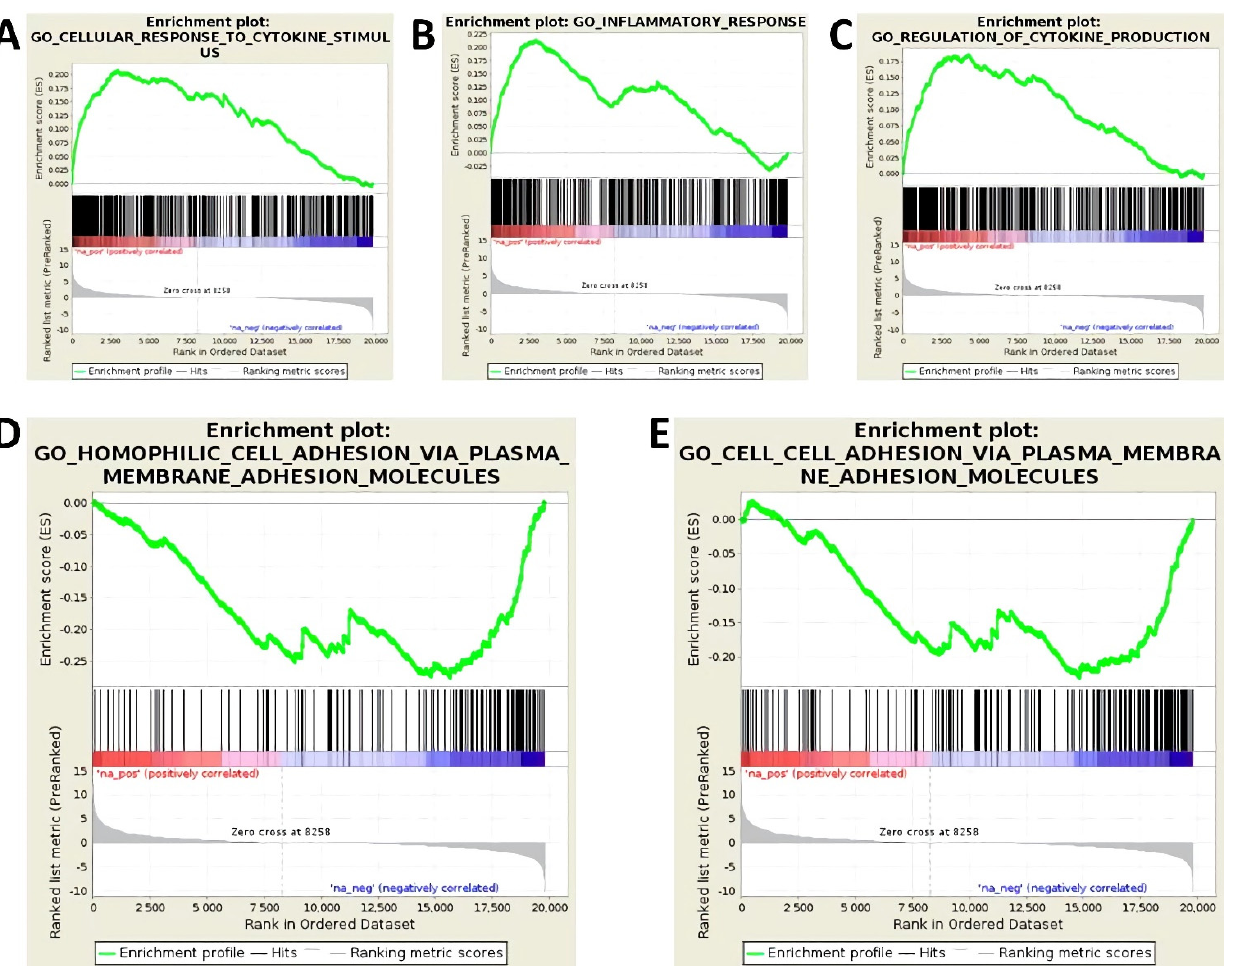
Figure 1. Human endothelial cells (cell line TIME, ATCC ® number CRL-4025) were evaluated following stimulation with 5 ng/mL each of IL-1 β , TNF- α , and IFN- γ for 24 h and compared to untreated controls. Three biological replicates were tested in each group. Transcriptome data obtained by next generation sequencing (NGS) were gathered into a gene set enrichment analysis (GSEA). Shown are 5 enrichment plots, which correspond to defined gene sets. ( A ) GO-Cellular-Response-To-Cytokine-Stimulation, ( B ) GO-Inflammatory-Response, ( C ) GO-Regulation-Of-Cytokine-Production, ( D ) GO-Homophilic-Cell-Adhesion-Via-Plasma-Membrane-Adhesion-Molecules, ( E ) GO-Cell-Adhesion-Via-Plasma-Membrane-Adhesion-Molecules. Each plot shows the running Enrichment score (ES) for the gene set, which reflects the degree to which a gene set is over-represented at the top or bottom of a ranked list of genes. A positive ES indicates gene set enrichment at the top of the ranked list (=upregulation); a negative ES indicates gene set enrichment at the bottom of the ranked list